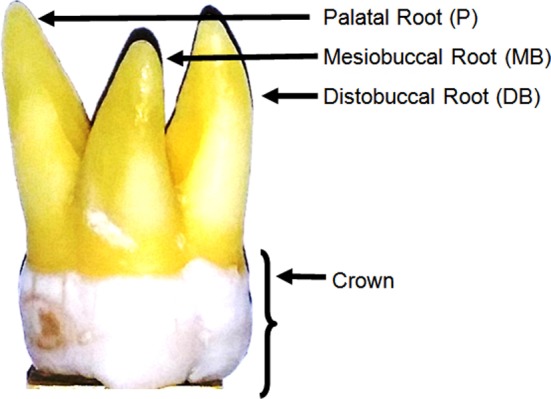
External anatomy of a typical maxillary molar with three diverging roots (mesiobuccal view).